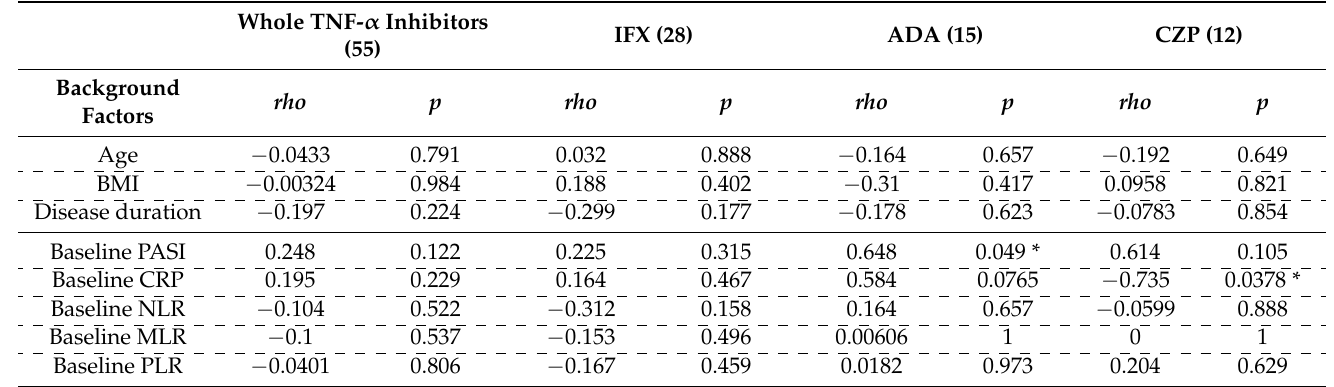
Table 6. The correlations between percentage reduction of psoriasis area and severity index (PASI) at week 52 versus age, body mass index (BMI), disease duration, baseline values of PASI or laboratory